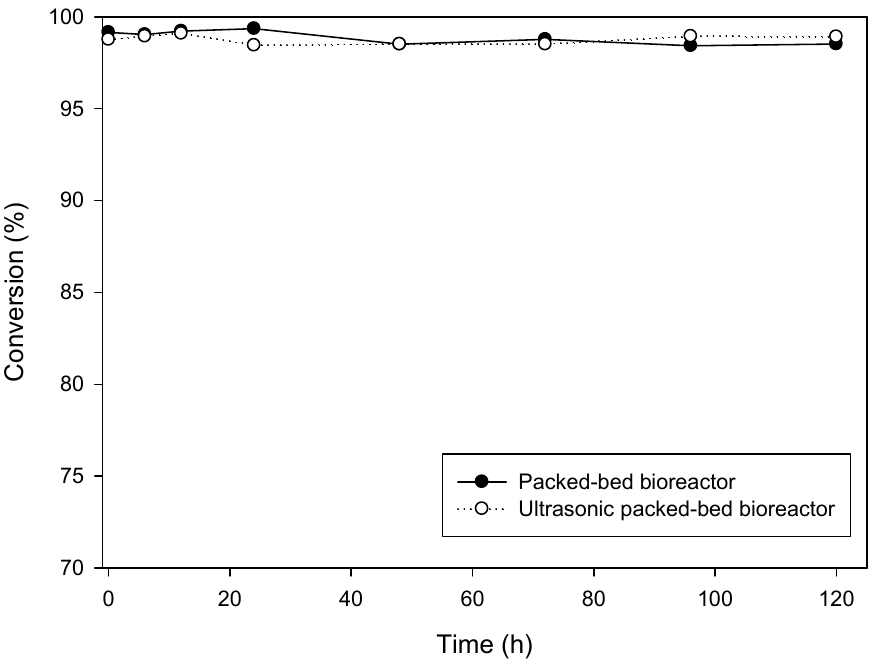
Figure 5. Long-term operation of ● packed-bed bioreactor and ○ ultrasonic packed-bed bioreac- tor for continuous synthesis of DHA + EPA ethyl ester.